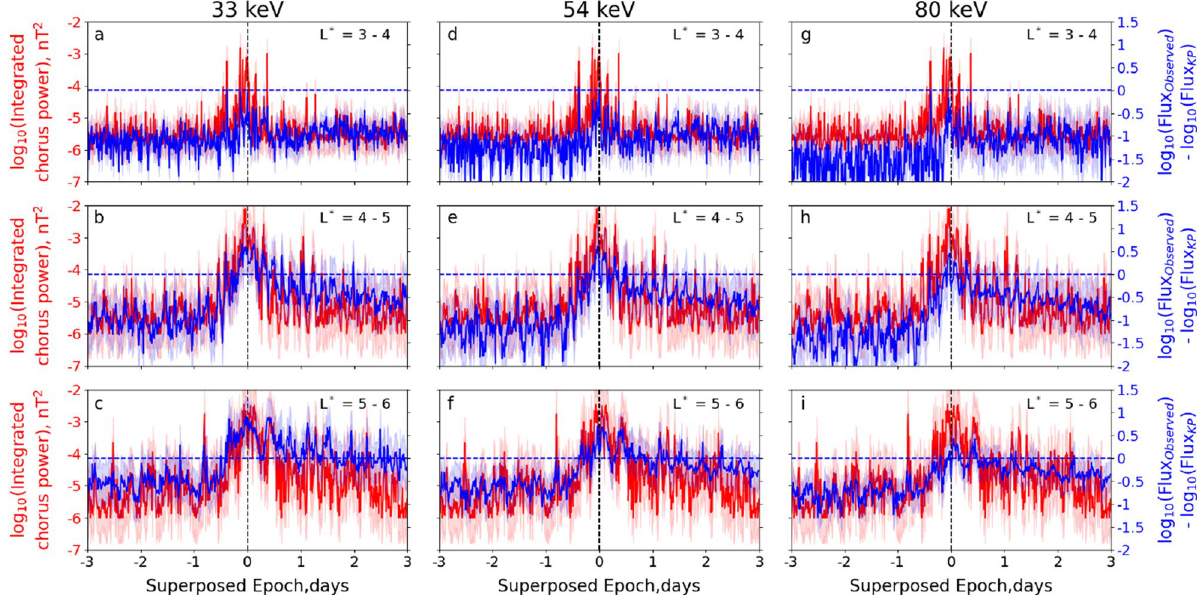
Figure 2. Superposed epoch analysis of integrated chorus wave power (0.1–0.8 f ce ; nT 2 ; red curves) and difference of observed flux and calculated KP limiting flux (blue curves) in logarithmic scale as a function of superposed epoch (in days) at three different electron energy channels: ( a – c ) 33 keV, ( d – f ) 54 keV and ( g – i ) 80 keV, and three different L ∗ ranges: ( a , d , e ) L ∗ = 3–4, ( b , e , h ) L ∗ = 4–5 and ( c , f , i ) L ∗ = 5–6, between 0 to 12 MLT. See text for